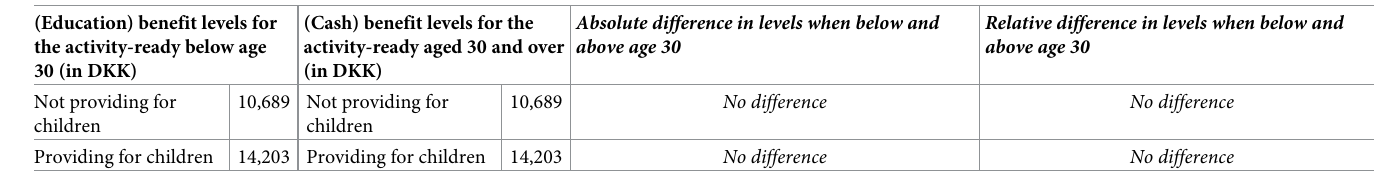
Table 2. Benefit levels for the activity-ready in 2014, by parenthood and age. (Education) benefit levels for the activity-ready below age 30 (in DKK)